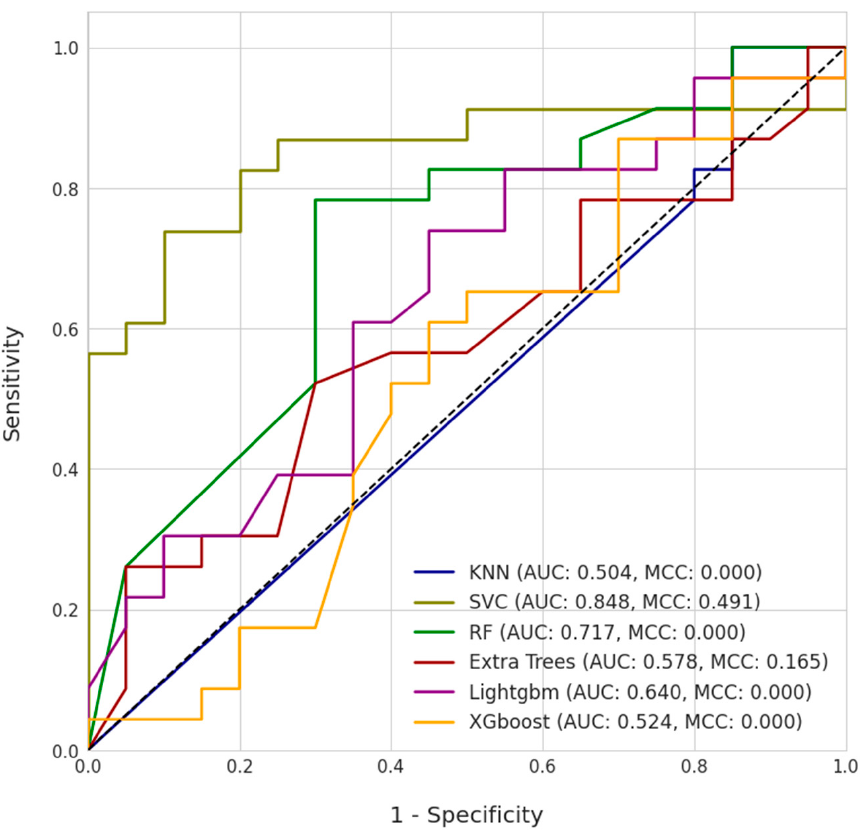
Figure 6. ROC curve, AUC, and MCC result for each model.